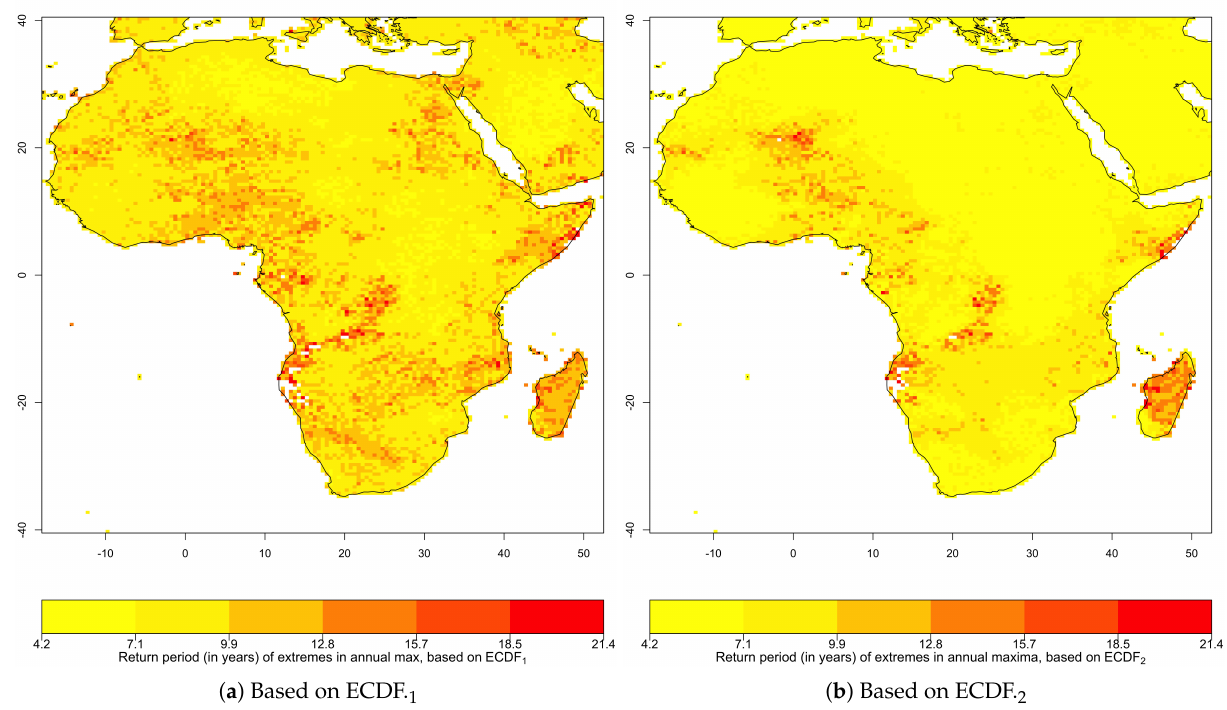
Figure 7. Return period of extremes in annual maximum temperatures: ( a ) based on ECDF 1 and ( b ) based on ECDF 2 . Return period based on ECDF 2 is shorter than that based on ECDF 1 in most places.